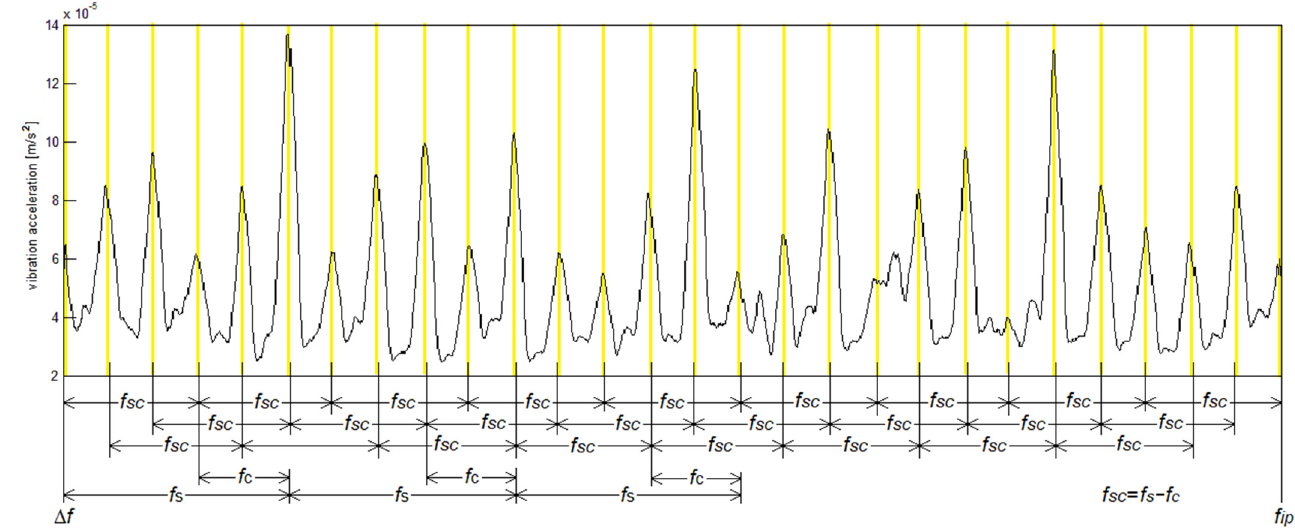
Figure 10. Resonance range vertical pattern intensity of F-F image presented in Figure 9. The maximum vertical pattern’s horizontal density is identical to the reference pattern position marked in Figure 10 by yellow vertical lines.